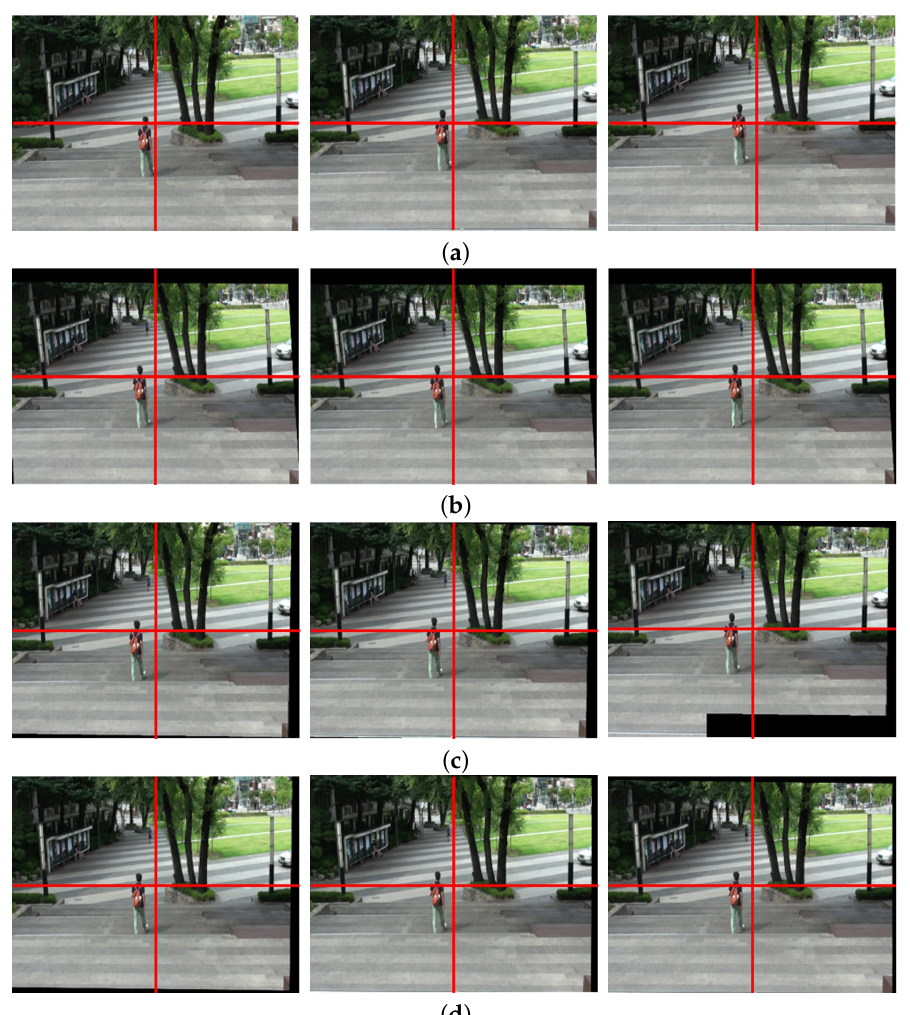
Figure 6. Experimental results of various video stabilization methods: ( a ) the input shaky video frames (80th, 81st, and 82nd frames), ( b ) the stabilized video using the global camera path using feature detection [7], ( c ) the bundled path algorithm [14], and ( d ) the proposed